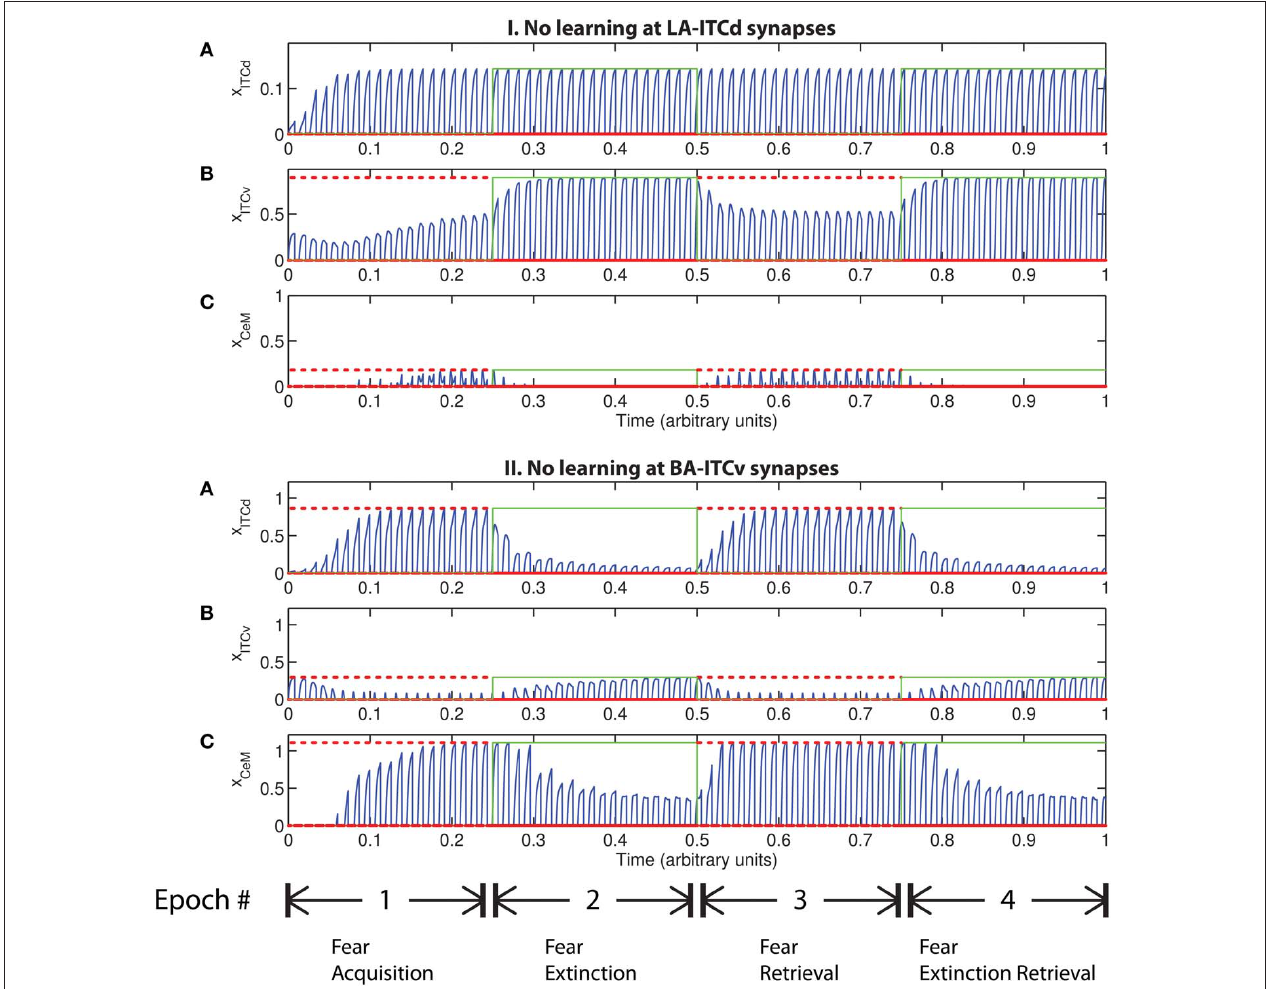
FIGURE 8 | Time evolution of model cell activities. (I) No learning occurs at the LA-ITCd synapses. (II) No learning occurs at the BA-ITCv synapses. Each plot shows the temporal evolution of a single cell over four consecutive epochs, with the y-axis representing strength of activation. In the first and third epochs, the CS signals, shown in (A), co-occur with R + ,